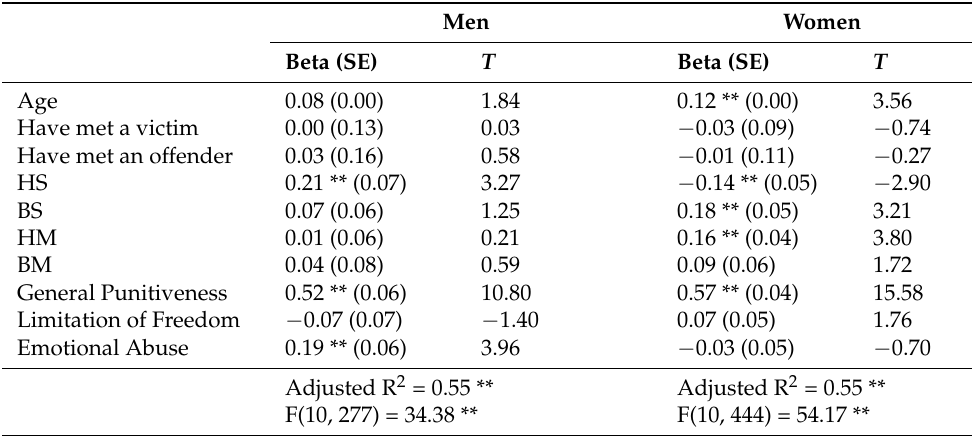
Table 3. Regression analyses predicting Sentencing and